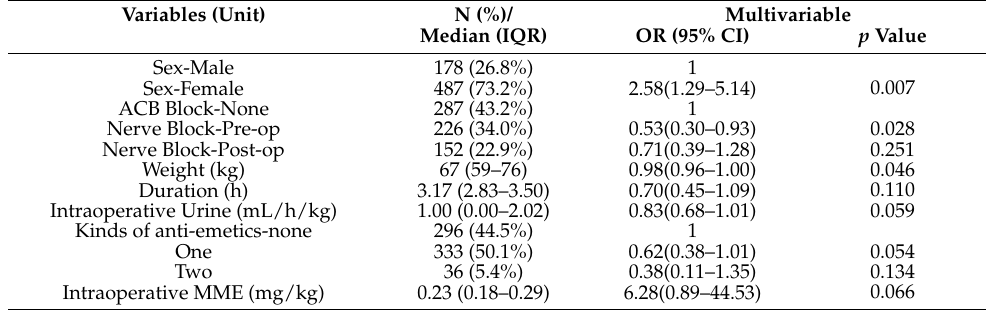
Table 3. Stepwise multivariate logistic regression of postoperative vomiting risk (backward